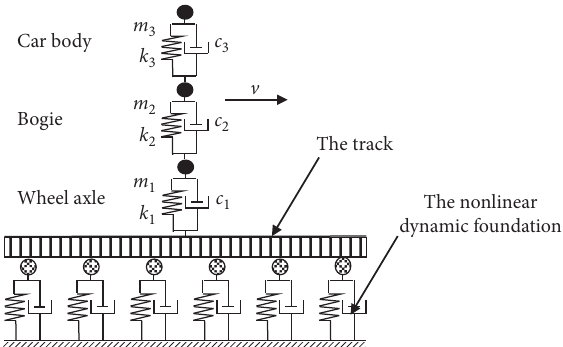
Figure 1: The problem model of track-train